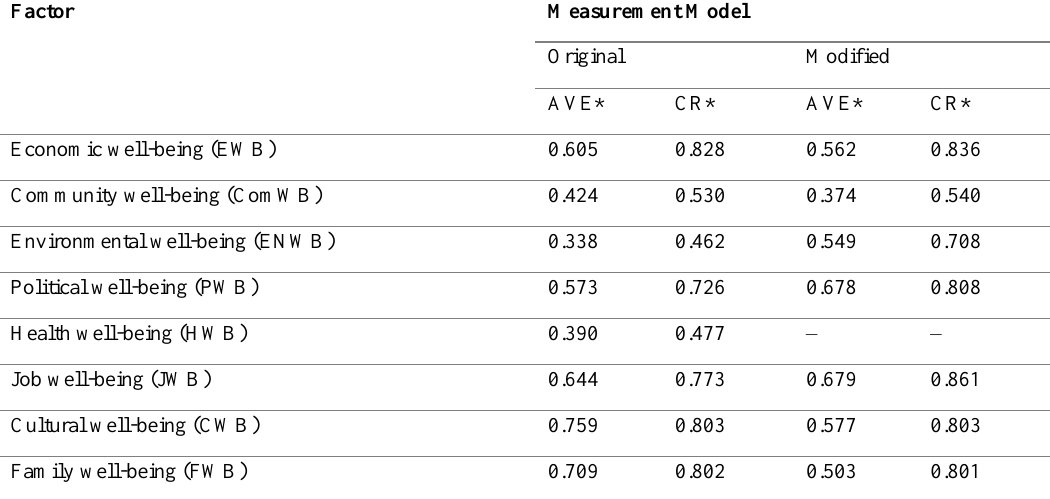
Table 2: AVE and CR for the original measurement